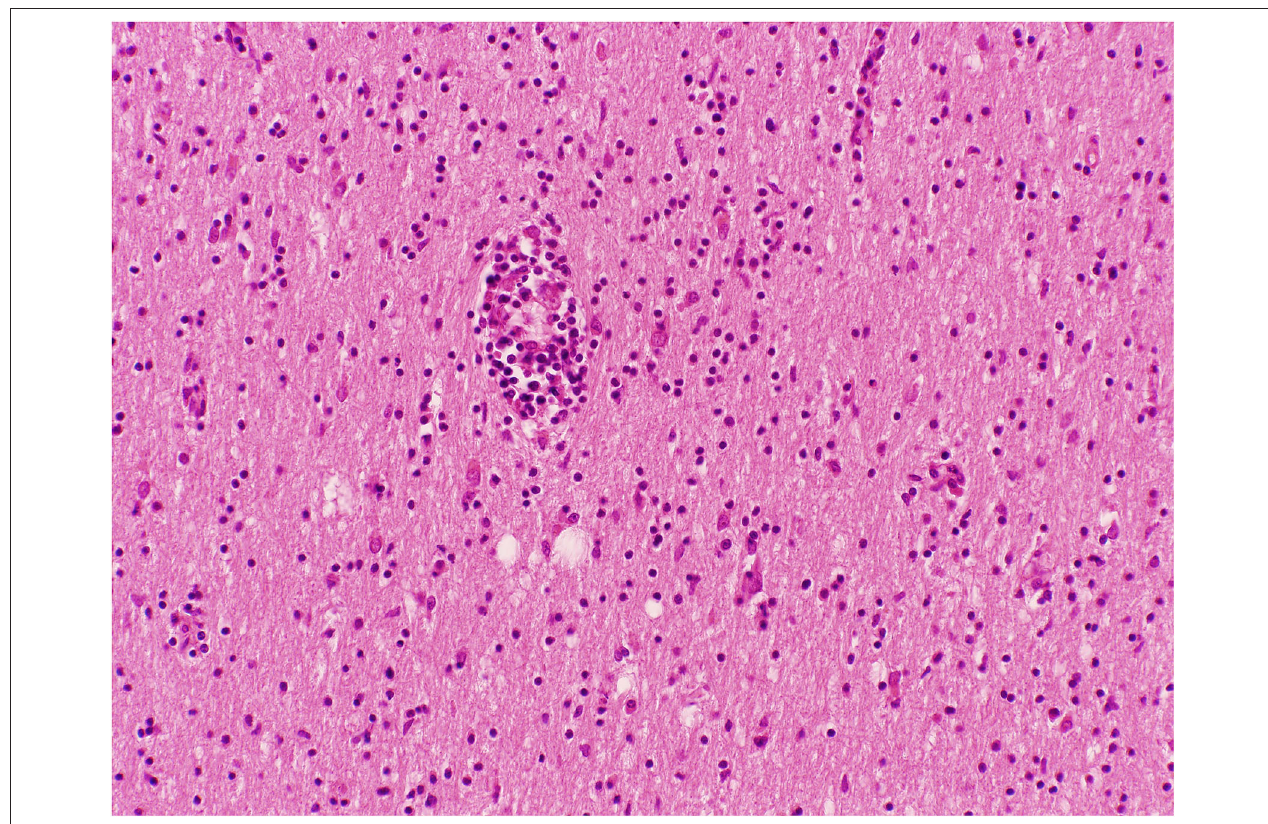
FIGURE 5 | Cerebral white matter with perivascular and diffuse lymphocytes in the neuropil; Haematoxylin and Eosin stain. Original magnification ×